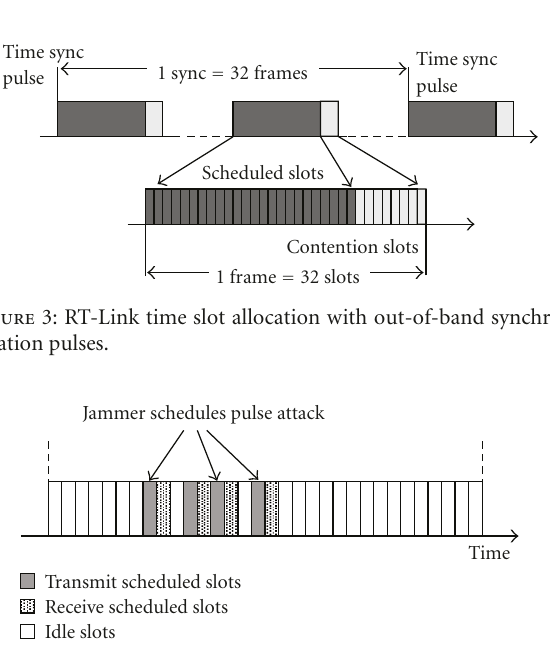
Figure 4: An attacker can learn node schedules and selectively jam active time